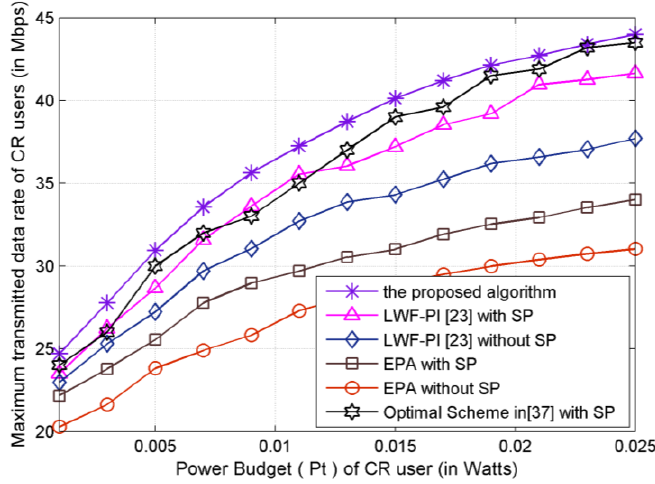
Figure 4. Maximum transmitted data rate versus Power Budget.